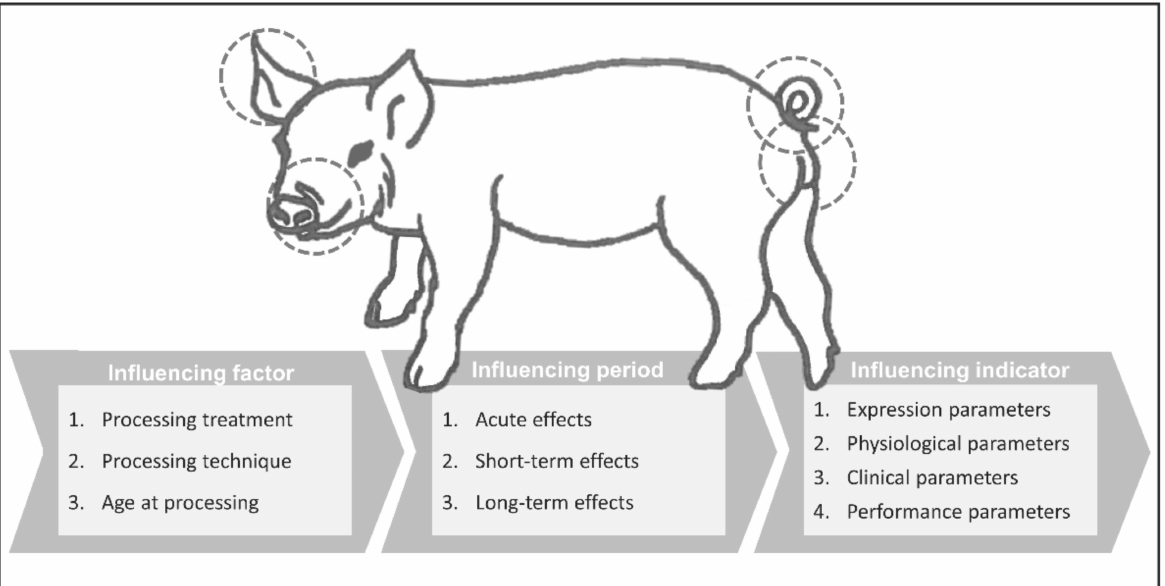
Figure 2. Influencing factors, periods, and indicators in the scope of the present review that describe the impact of piglet processing on animal